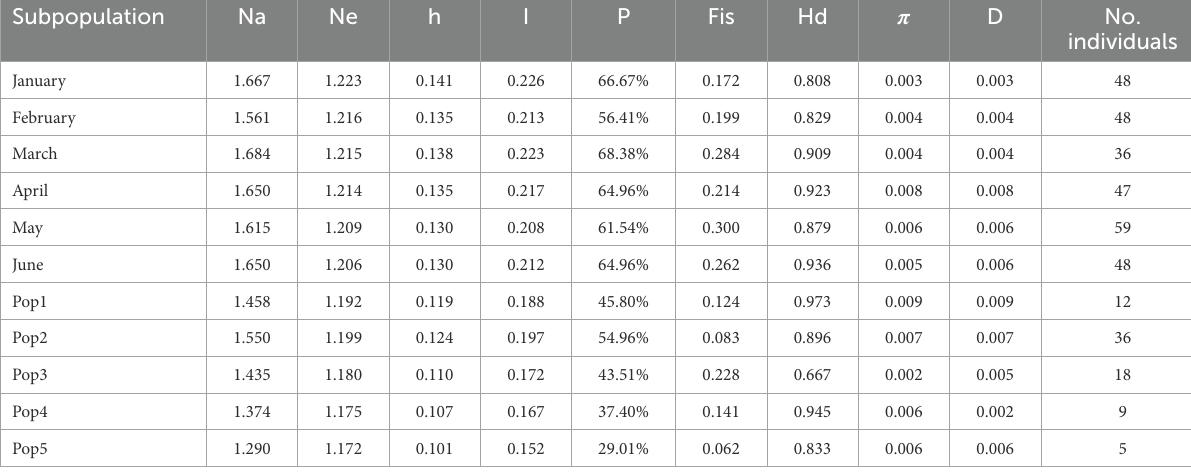
TABLE 1 Genetic diversity indexes of 11 D. sinensis groups in Lake